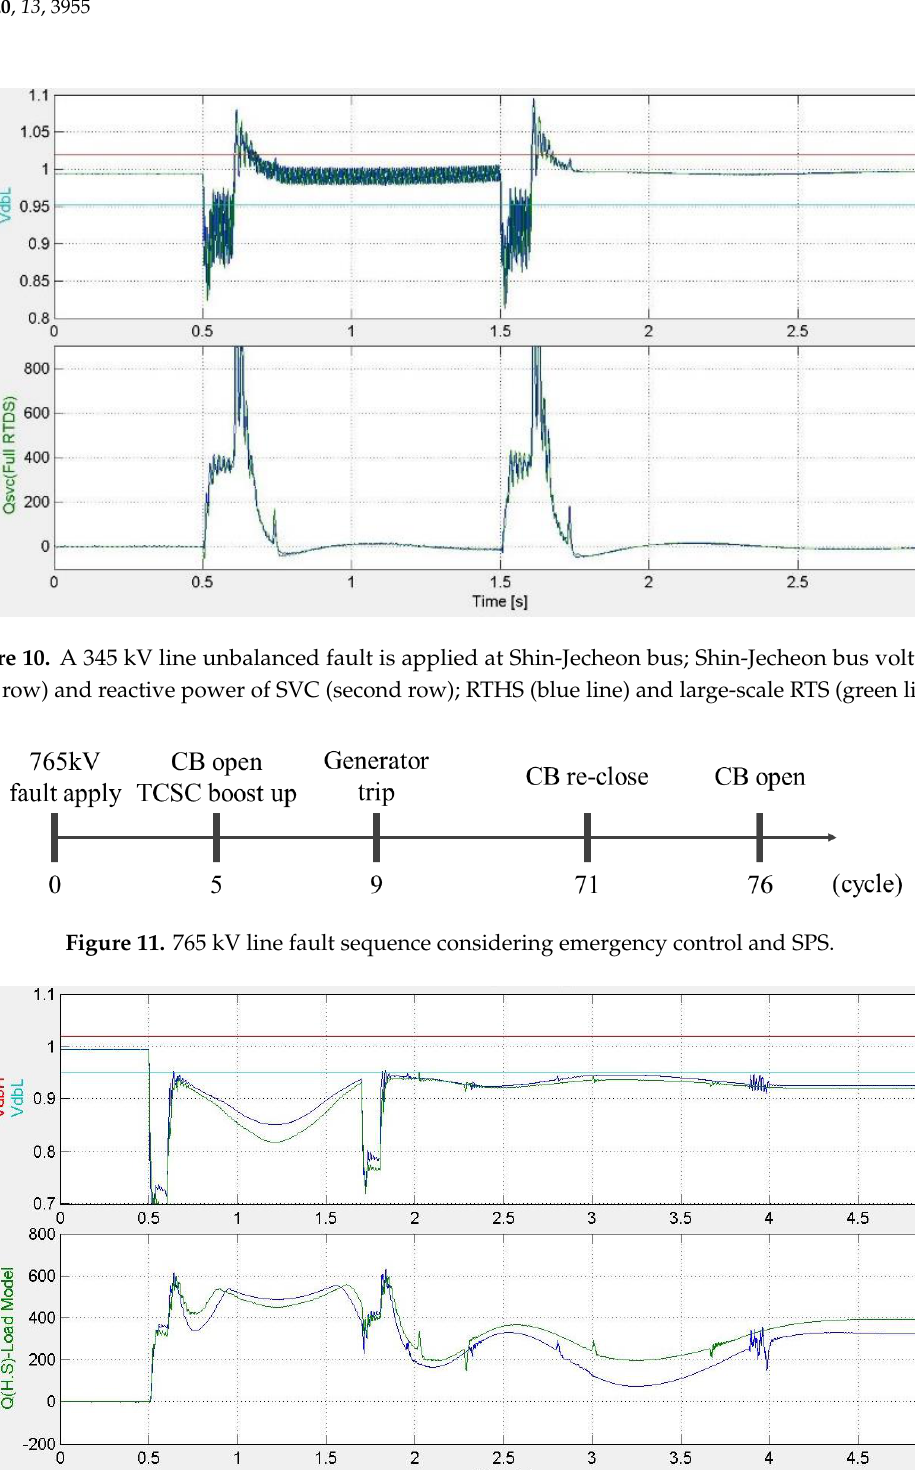
Figure 10. A 345 kV line unbalanced fault is applied at Shin-Jecheon bus; Shin-Jecheon bus voltage (first row) and reactive power of SVC (second row); RTHS (blue line) and large-scale RTS (green line)